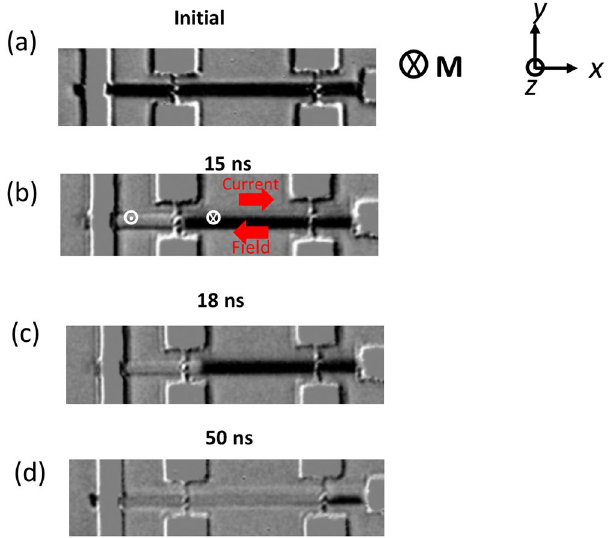
Figure 3. Direct observation of SOT-driven DW motion in Ta/Pt/Co/Pt/Co/Ta structure using Kerr imaging technique. ( a ) Initial magnetization state in − z -direction. ( b ) DW motion after the application of a 15 ns pulse, the DW propagates 8 µ m distance and reaches the first Hall probe ( c ) application of 18 ns pulse, DW depins from the Hall probe and propagates a distance of 10 µ m and ( d ) application of 50 ns pulse, DW reaches second Hall probe propagating a distance of 25 µ